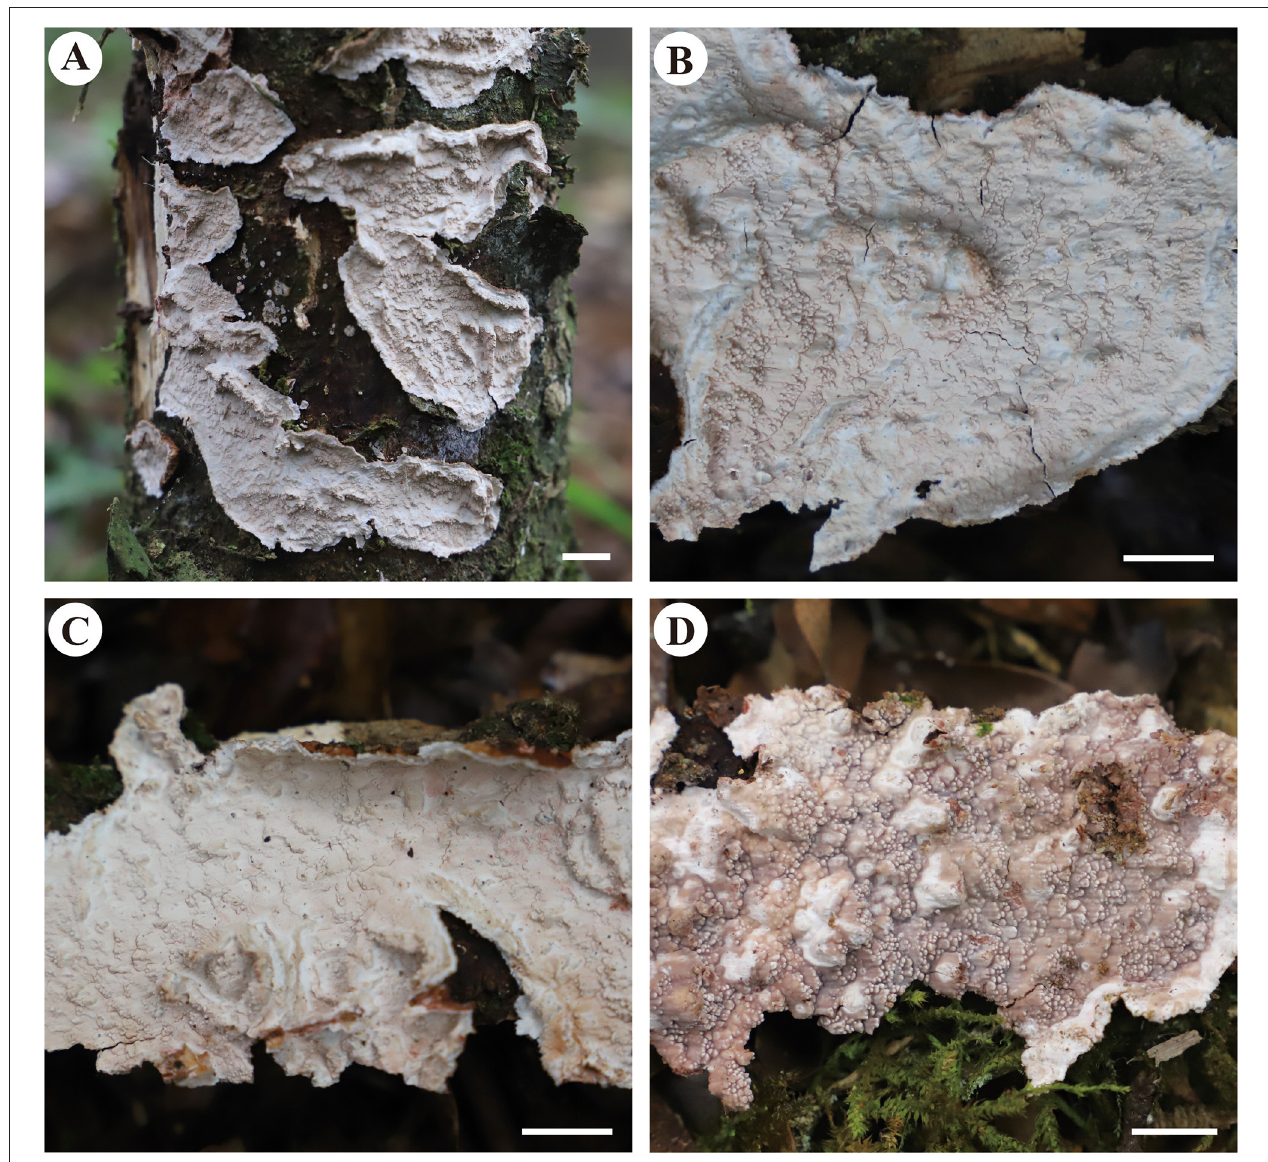
FIGURE 9 | Basidiomata of Irpex rosea [from He 6277; scale bars: (A–D) = 1cm].